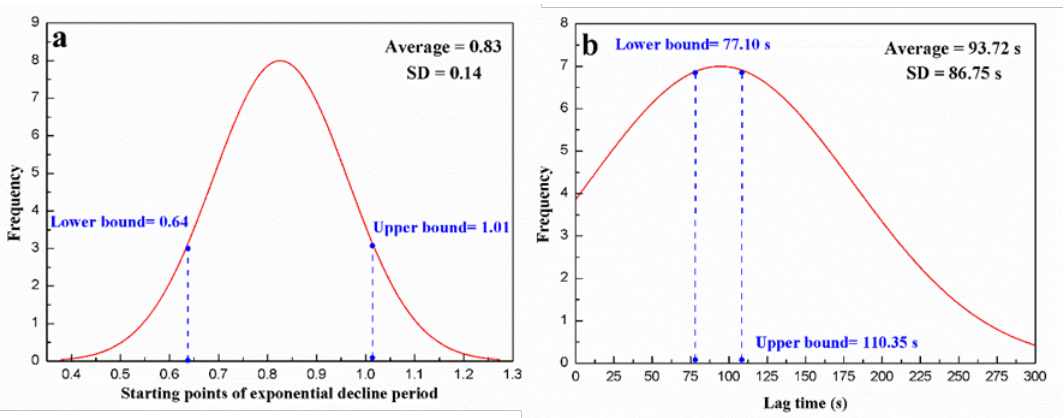
Figure 4. Normal distributions of starting points of exponential decline period ( a ) and lag time ( b ) in our